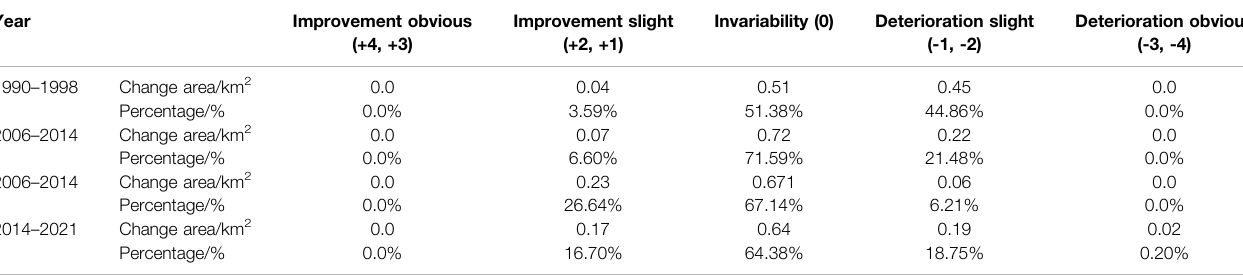
TABLE 5 | Change detection of the RSEI level from 1990 to